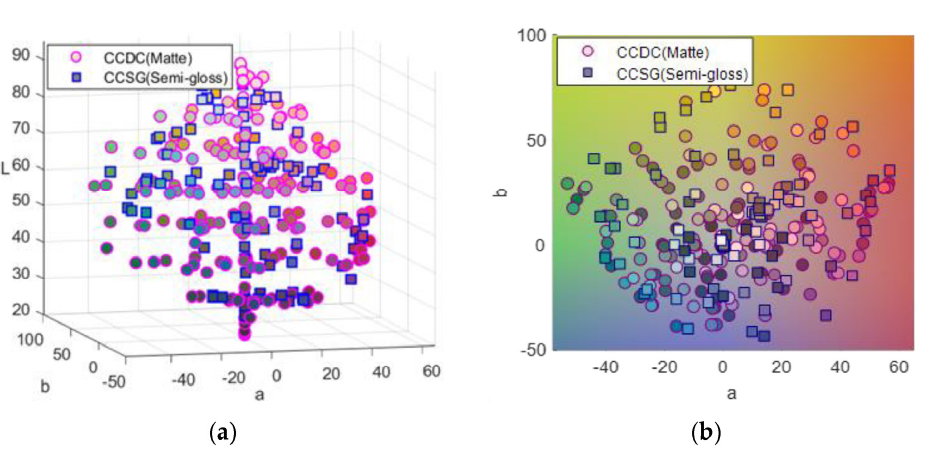
Figure 3. The color distribution of matte charts (circle marker) and semigloss charts (square maker). ( a ) Comparison of color distribution in the CIELAB color space. ( b ) The chromaticity coordinates of samples in a* − b*